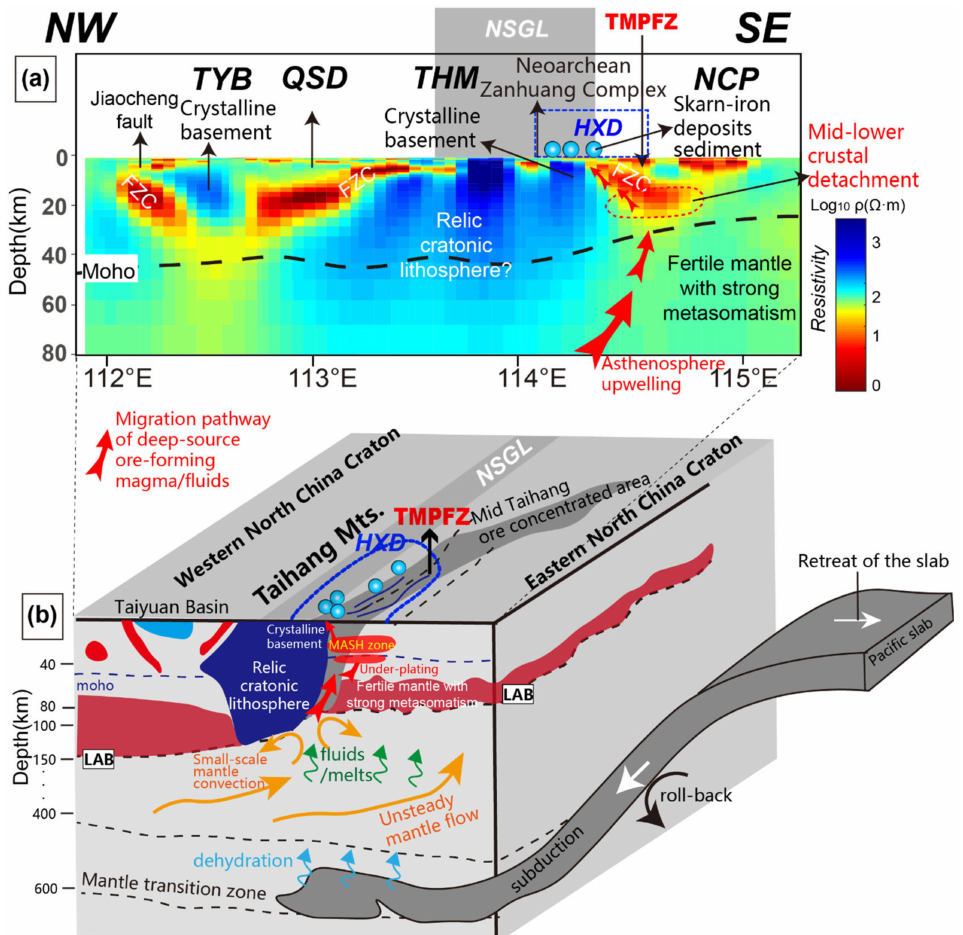
Figure 6. ( a ) General geological interpretation for the vertical slice of the 3D inversion model along P1 in Figure 4. ( b ) An integrated 3D sketch diagram illustrating possible metallogenic mechanisms of the HXD inferred from the crustal and upper mantle electrical structure derived from this research. The deep structure (>80 km) in ( b ) was determined or modified according to previous studies [26,27,49], while the shallower part of this sketch is mainly based on the geological interpretation in ( a